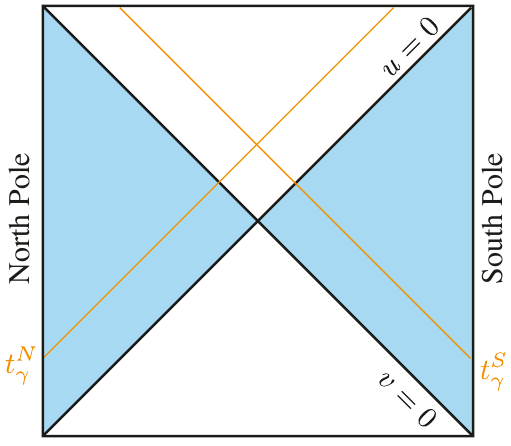
Figure 2 . De Sitter Penrose diagram and global lightcone coordinates. The two static patches are shaded